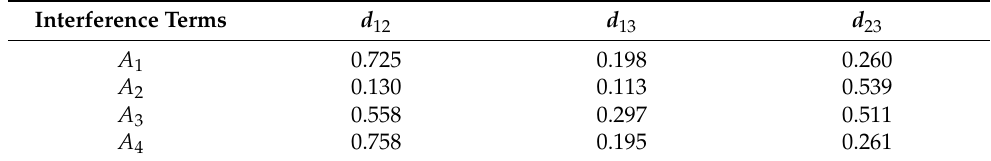
Table 11. The value of interference terms of LDAR i .